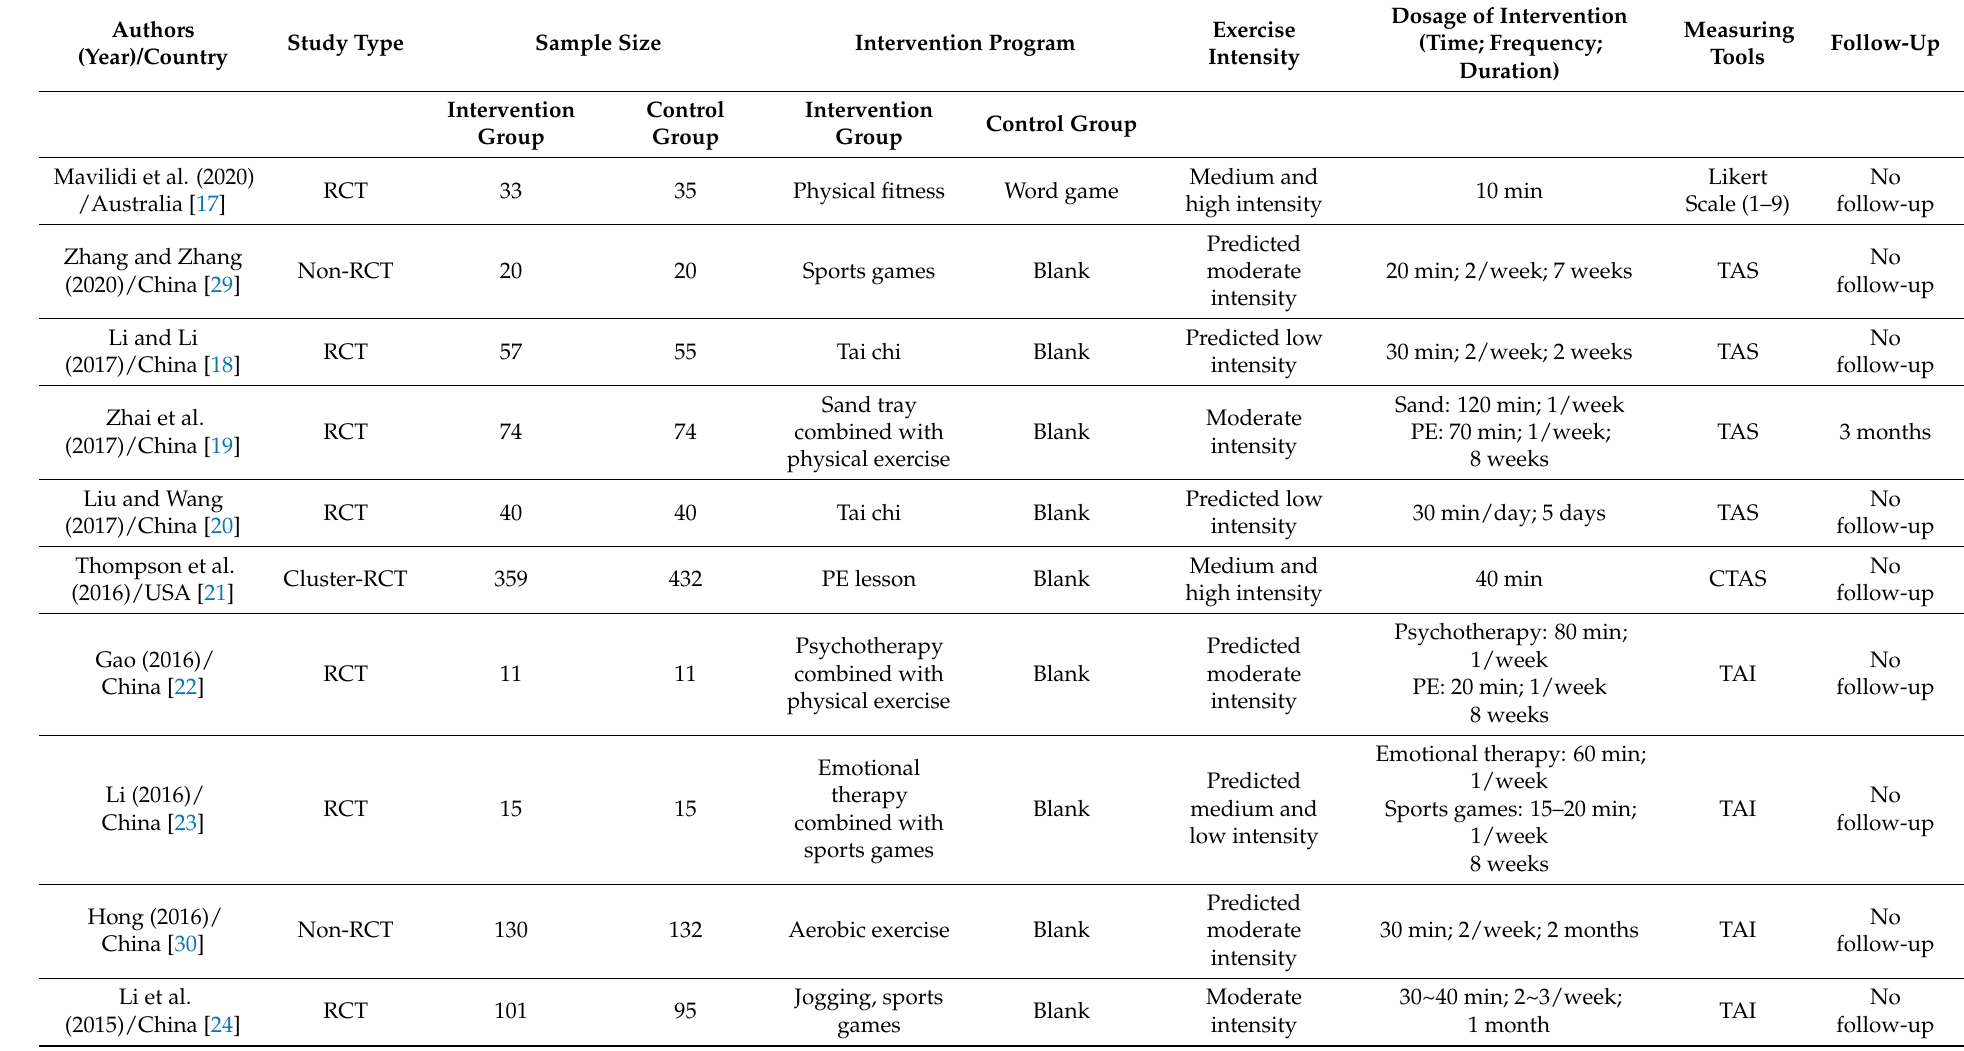
Table 2. The basic characteristics of included